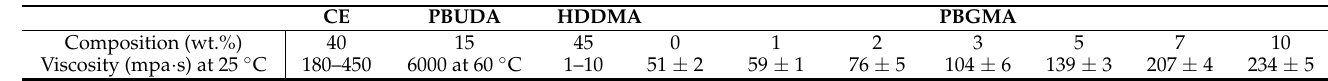
Table 3. Composition of the reference formulation and the formulations modified with various concentrations of PBGMA, and their associated viscosities measured at 25 °C.